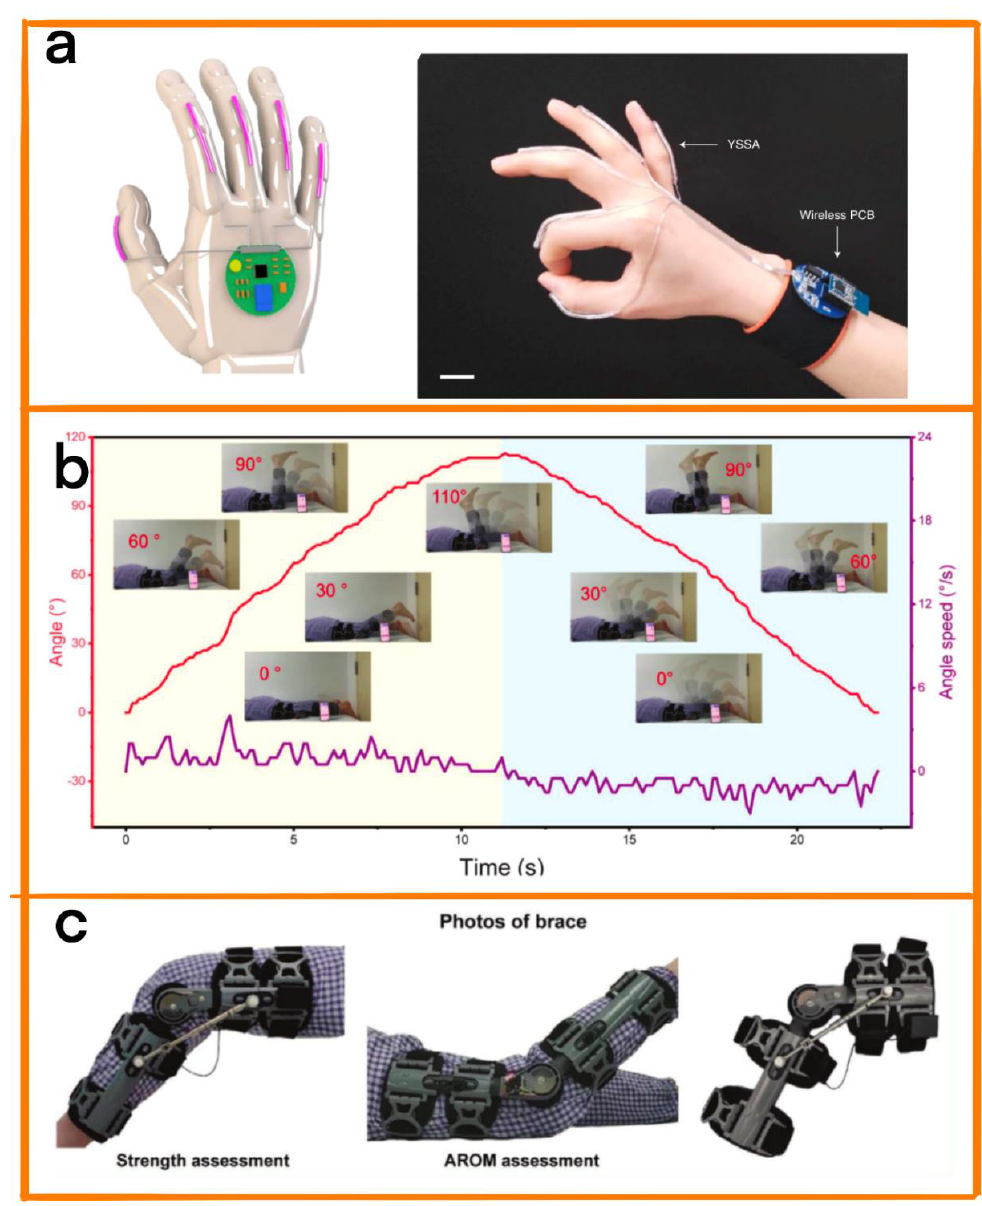
Figure 12. ( a ) Schematic diagram of a wearable sign language voice translation system. Reprinted with permission from [91]. 2020, Elsevier. ( b ) Real − time angle signal, angle speed, and photos within the range of motion. ( c ) Schematic diagram of rehabilitation brace system. Reprinted with permission from [93]. 2022, Elsevier.